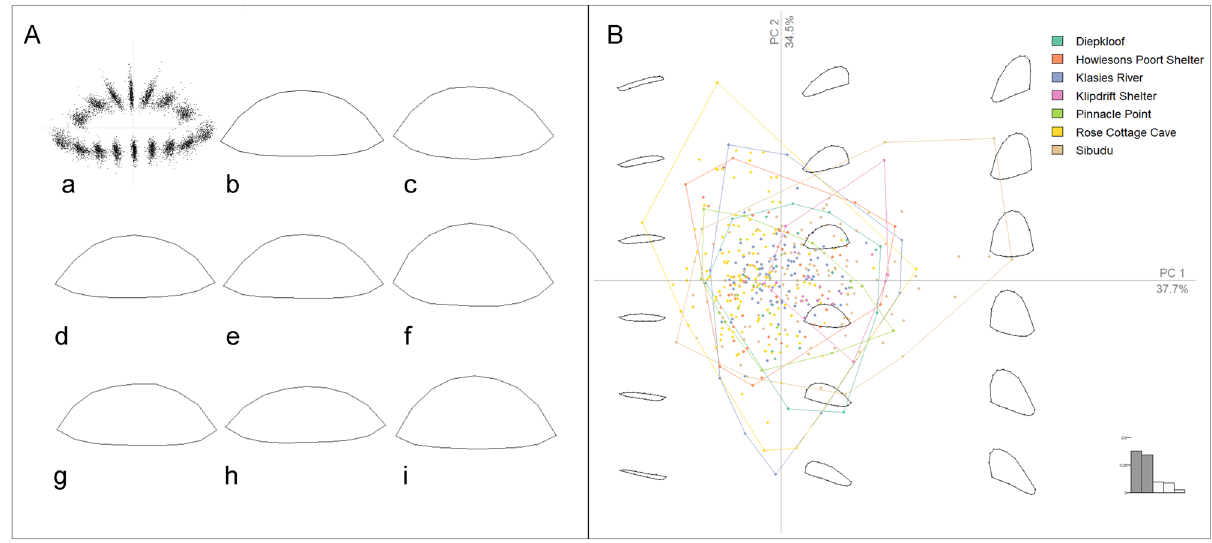
Figure 2. ( A ) GPA stack and mean shape of the backed artifacts from the seven southern African sites under study: (a) GPA stack of the 459 backed artifacts from the seven sites, (b) mean shape of all 459 southern Africa backed artifacts, followed by the mean shape of the backed artifacts from each site (c) Diepkloof, (d) Howiesons Poort Shelter, (e) Klasies River, (f) Klipdrift Shelter, (g) Pinnacle Point, (h) Rose Cottage Cave, (i) Sibudu; ( B ) Convex hulls representing variation along the first two principal components of the South African backed artifact assemblages. The percentage explained variance for each axis is in parentheses. Note the absence of clear between-group shape differences with the exception of a few outlying backed artifact shape configurations, principally from Sibudu. This figure was created in RStudio 1.4 www. rstud io. com by